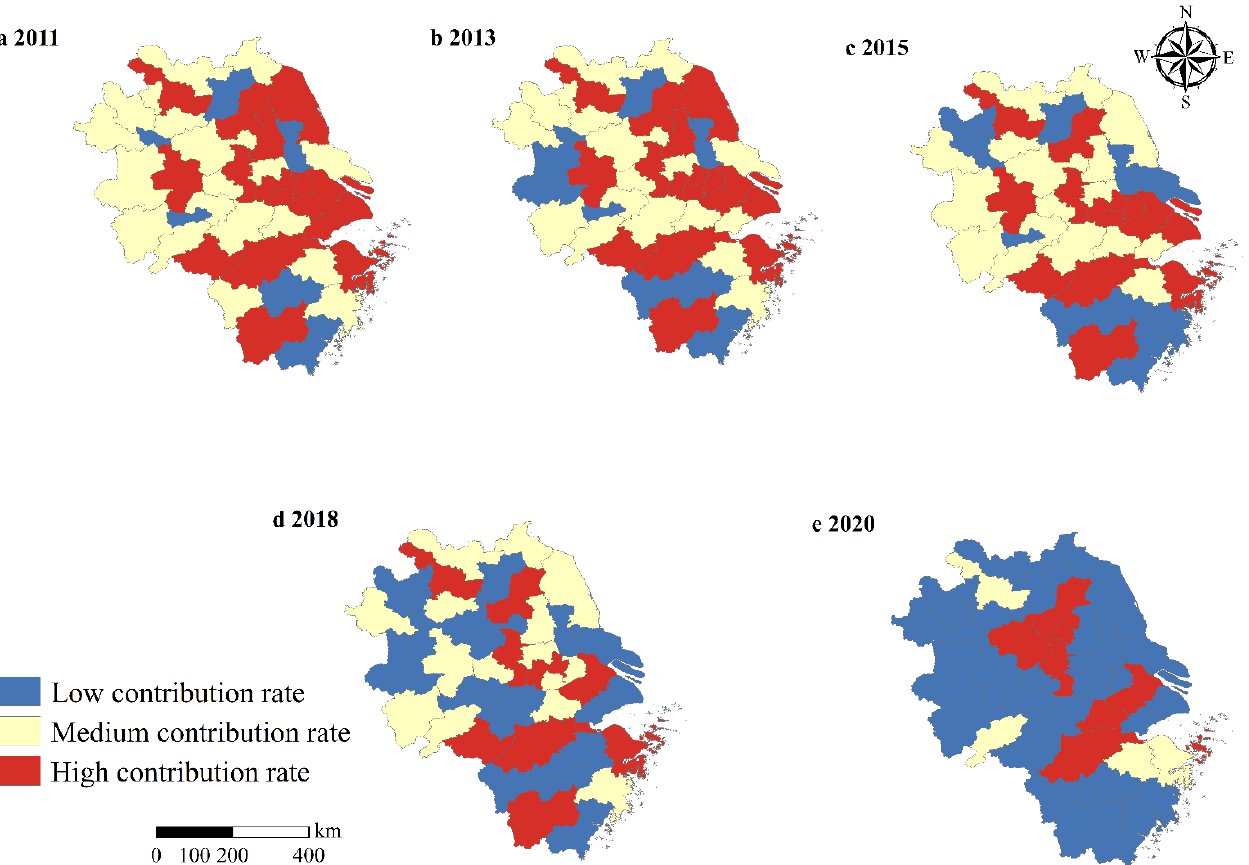
Figure 2. Average contribution rate of GASTP in the YRD and its provinces from 2011 to 2020.